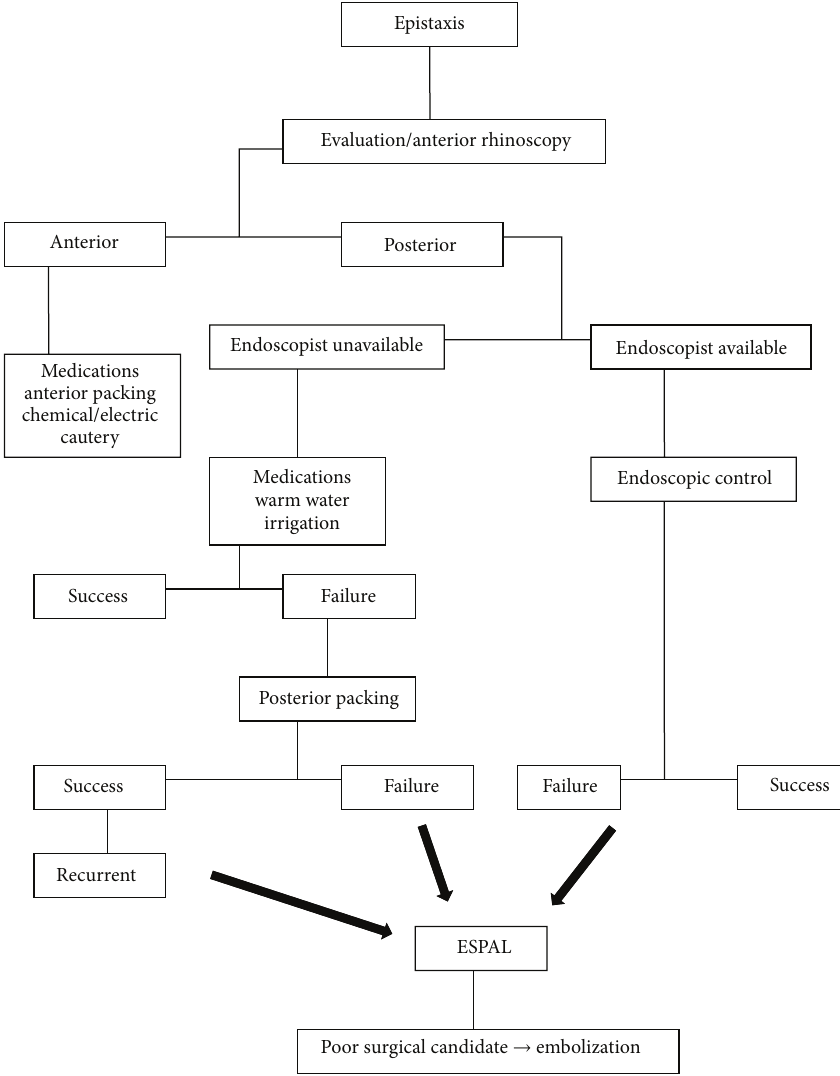
Figure 3: Algorithm for the management of